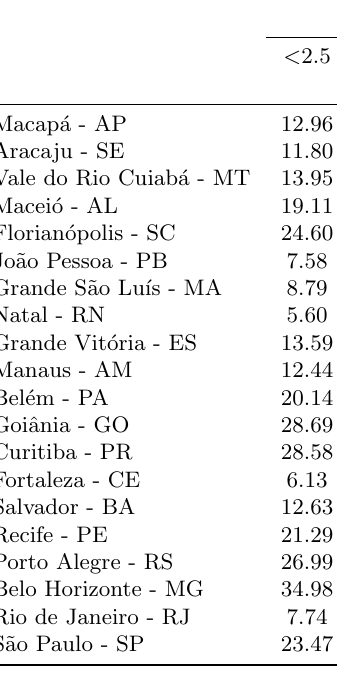
Table A.1: Average hourly wage (in Brazilian real) in each weighting area by the distance to the main business centre,